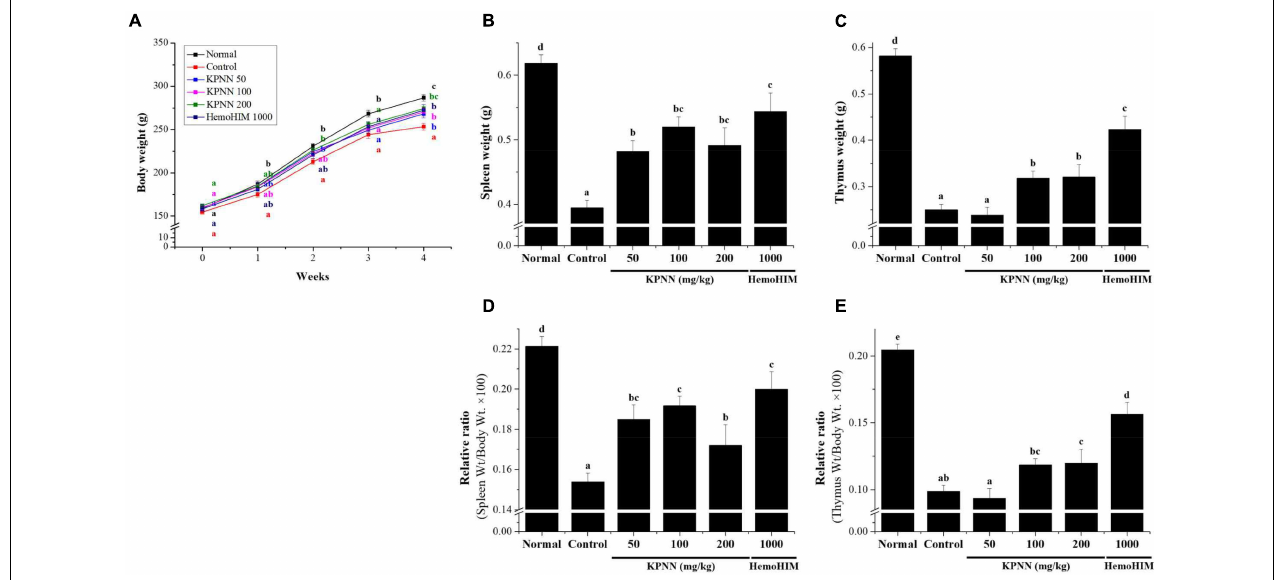
FIGURE 6 | Effects of KPNN on thymus and spleen damage in rats with Cy-induced immunosuppression. The 60 Wistar rats were divided into six groups of 10 animals each and were administered orally for 4 weeks: normal control group (Normal), immunosuppression group (Control), immunosuppression + KPNN 50 mg/kg group (KPNN 50), immunosuppression + KPNN 100 mg/kg group (KPNN 100), immunosuppression + 200 mg/kg group (KPNN 200), and immunosuppression + HemoHIM 1000 mg/kg group (HemoHIM 1000). (A) Body weights were measured once per week. The indices of (B) spleen and (C) relative ratio (weight/body weight × 100), (D) thymus, and (E) relative ratio (wt./body wt. × 100). Data are expressed as mean ± SEM of three independent experiments, p < 0.05 compared to the control group ( n = 10). Bars labeled with different superscript numerals indicate p <